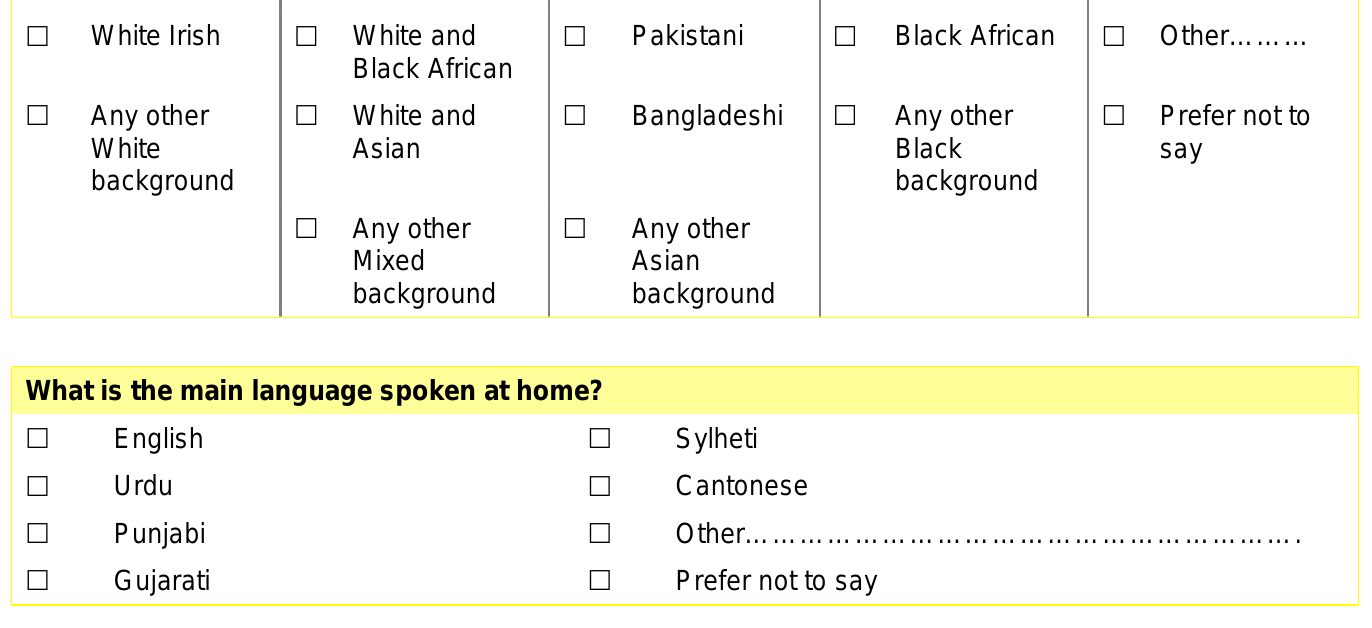
Cervical Cancer Awareness Measure Toolkit Version 2.1 Updated